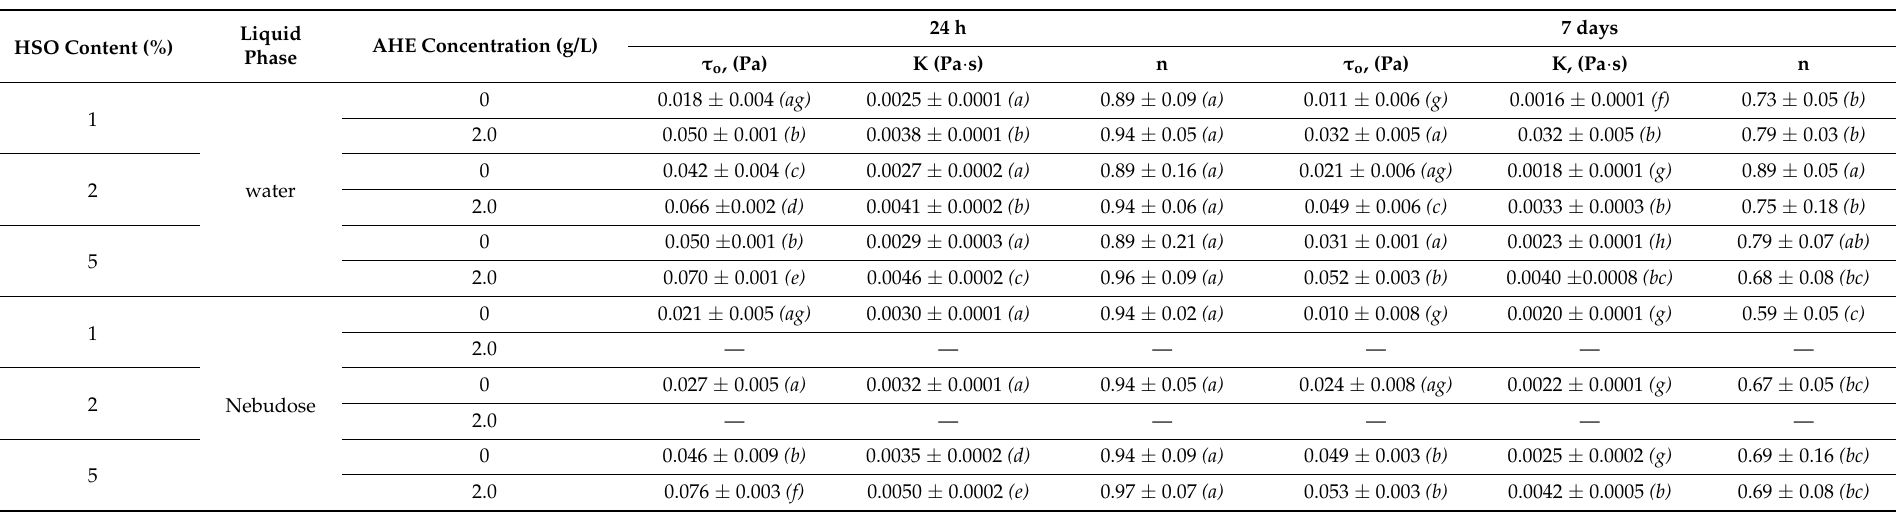
Table 5. Average value and SD of the parameters of the Herschel–Bulkley model describing the flow curves of the O/W emulsions: shear stress ( τ 0 ) consistency coefficient (K), flow index